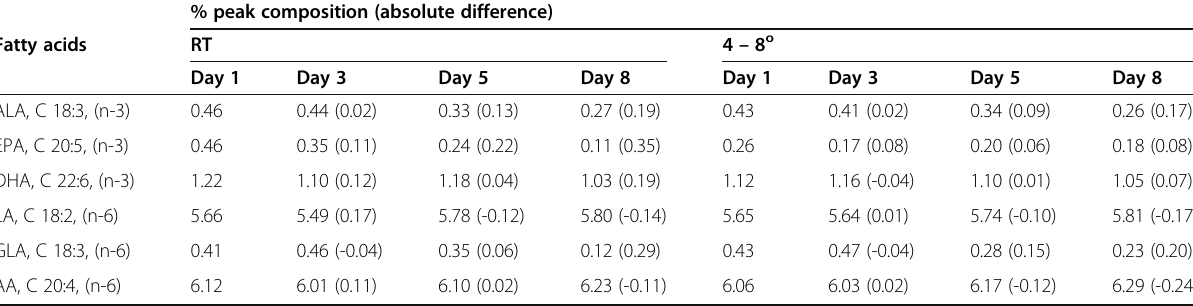
Table. 8 Stability results after storage of methyl esters at different temperatures % peak composition (absolute